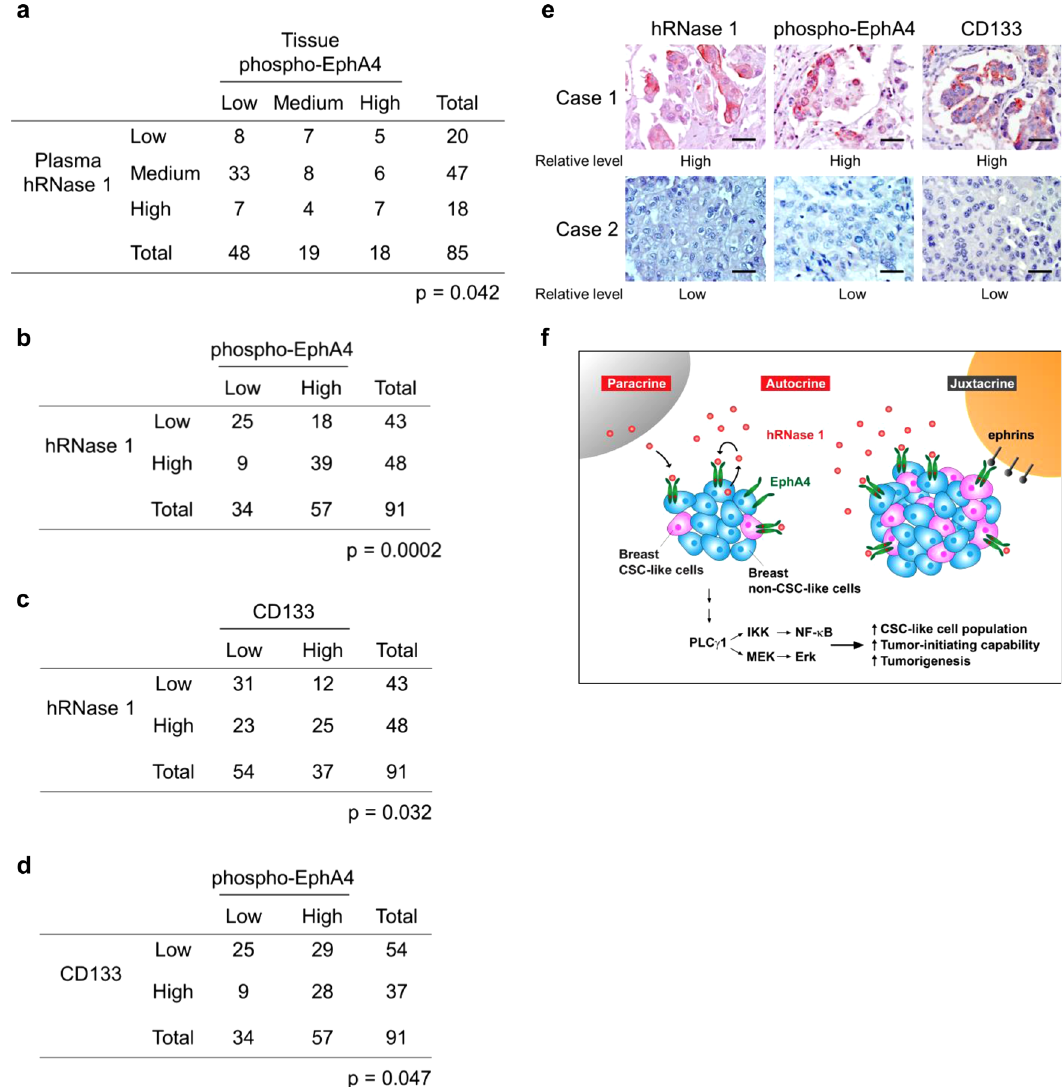
Fig. 7 Pathological relevance of hRNase 1 expression, EphA4 activation, and CD133 in breast cancer. a Quanti fi cation for the correlation between tissue phospho-EphA4-Y779 and plasma hRNase 1 in the paired breast cancer patients. Chi-squared test. b – d Quanti fi cation of IHC staining for the correlation between hRNase 1 and phospho-EphA4-Y779 ( b ), hRNase 1 and CD133 ( c ), and CD133 and phospho-EphA4-Y779 ( d ) by human breast TMA analysis (Pantomics Inc., #BRC1021). Fisher ’ s exact test. e Two representative cases of IHC staining for ( b – d ). The experiment was performed an additional time with similar results. Bar, 50 μ m. f A proposed model of hRNase 1 as a secretory ligand of EphA4 to positively regulate breast tumor initiation. In brief, elevated levels of serum hRNase 1 induces its binding to EphA4 and triggers EphA4 signaling (red stars) in breast tumor cells in an autocrine/paracrine manner, which in turn promotes breast tumor initiation via the IKK/NF- κ B and MEK/Erk activating pathways. Such EphA4 activation and CSC-like state triggered by hRNase 1 may be sustained in conjunction with juxtacrine signaling via the classical membrane-bound EphA4 ligands, ephrins. Artwork by H- H.L., Y-N.W., and